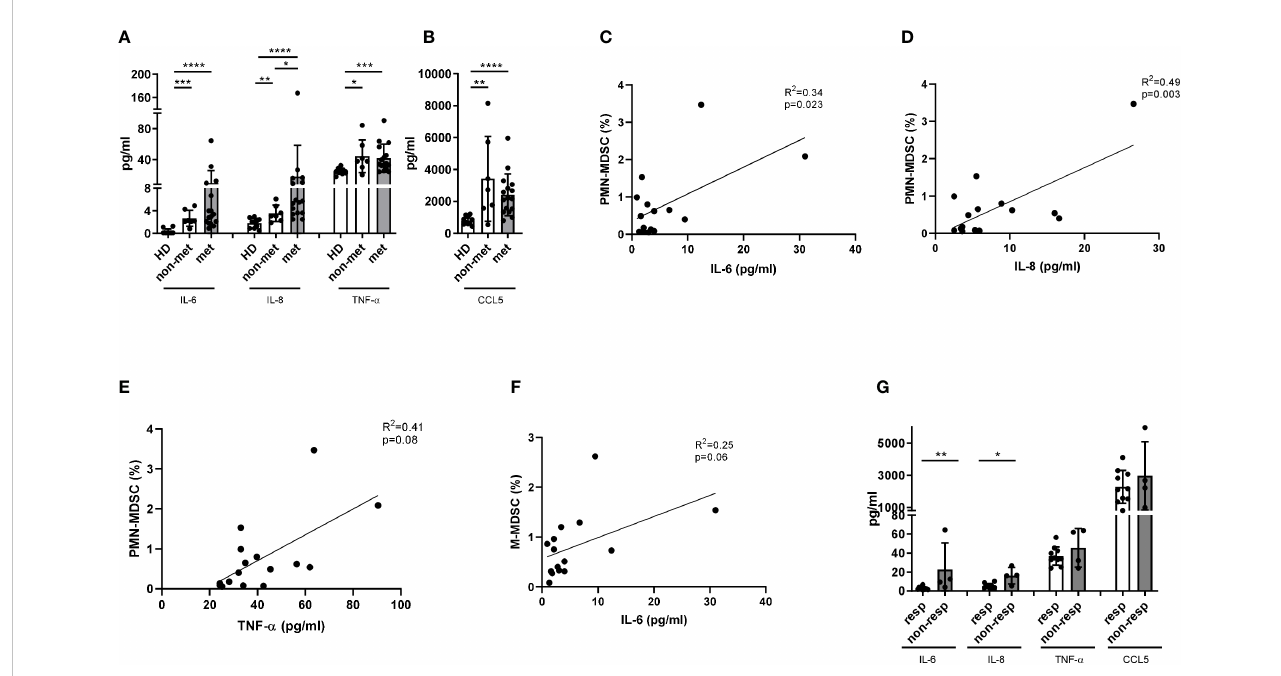
FIGURE 4 Production of in fl ammatory factors in melanoma patients at the baseline. Concentrations of IL-6, IL-8, TNF- a (A) and CCL5 (B) were detected in plasma of metastatic (n=16) and non-metastatic (n=7) patients as well as HD (n=10) by bio-plex assay and expressed as pg/ml. The frequency PMN-MDSC among PBMC were plotted against the level of IL-6 (C) , IL-8 (D) and TNF- a (E) in metastatic melanoma patients (n=15). The correlation was evaluated by a linear regression analysis. (F) The frequency M-MDSC within PBMC were plotted against the level of IL-6 in metastatic melanoma patients (n=15). The correlation was evaluated by a linear regression analysis. (G) Concentrations of IL-6, IL-8, TNF- a and CCL5 in plasma from metastatic patients, responding (n=10) and non-responding (n=4) to the ICI treatment are expressed as pg/ml. * P < 0.05, ** P < 0.01, ***P < 0.001, **** P <